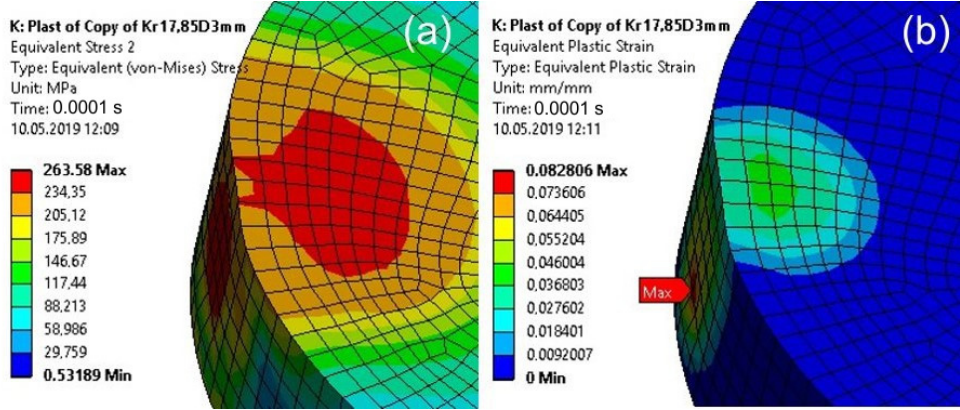
Figure 18. The von Mises Stress in the upper element of the specimen ( a ) and its plastic strain ( b ) for a 0.0001 s calculation time after taking into account the plastic properties of the upper element—Model 2 (nonlinear analysis).